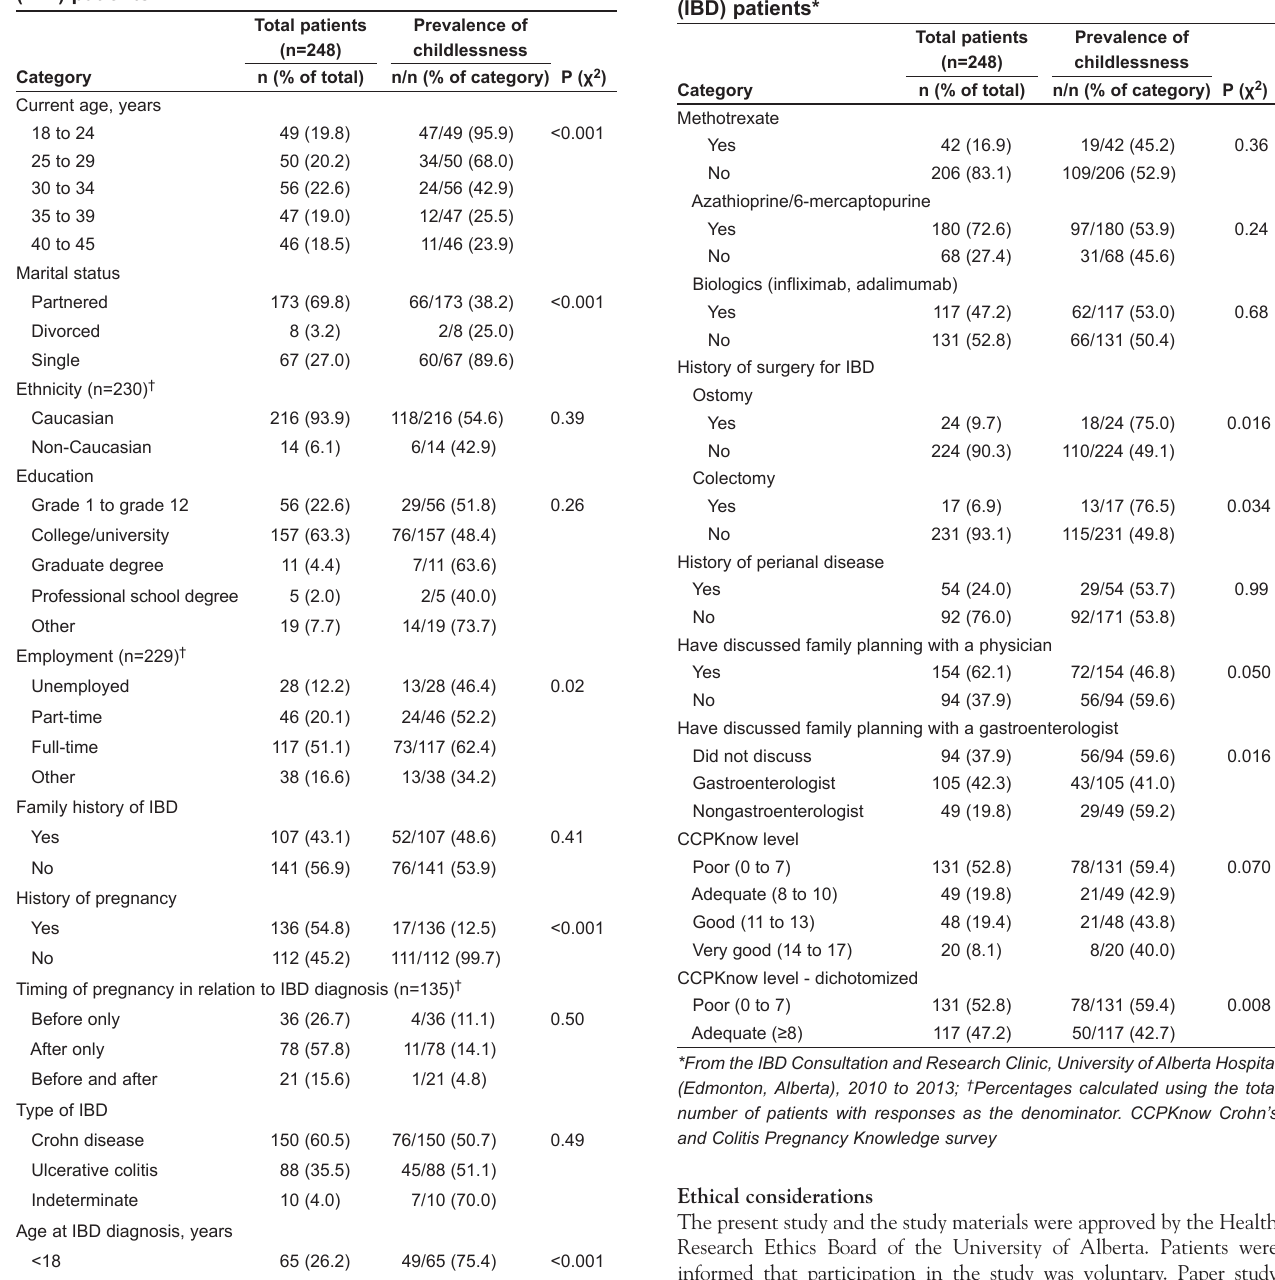
TABLE 1 Prevalence of childlessness according to selected study variables among 248 female inflammatory bowel